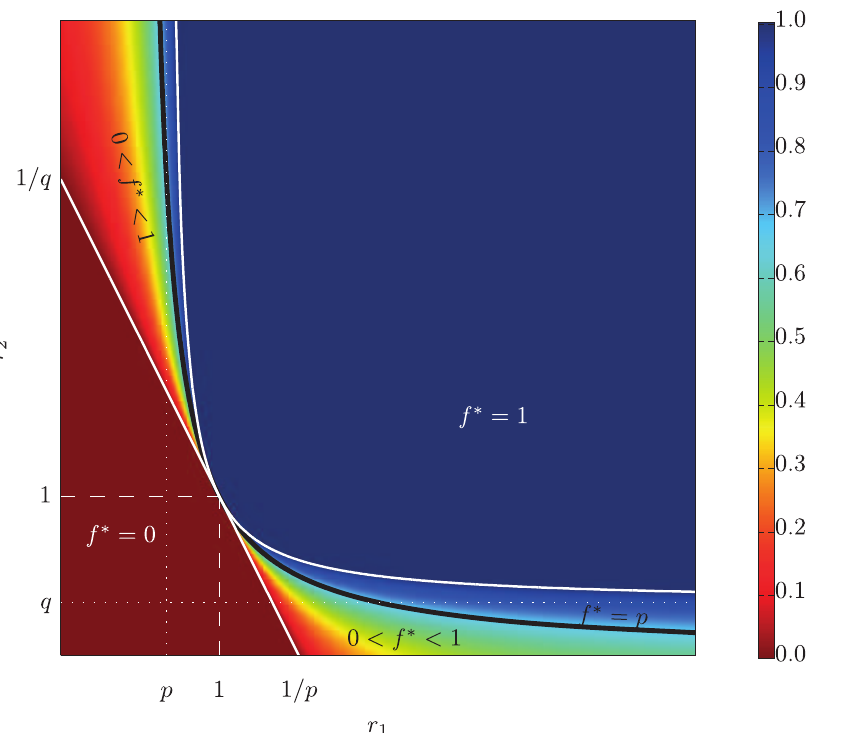
Figure 1. Regions of the ( r 1 , r 2 ) -plane that imply deterministic ( f (cid:2) ~ 0 or 1 ) or randomizing ( 0 v f (cid:2) v 1 ) behavior, where r j ~ c aj = c bj measures the relative fecundities of action a to action b in the two states j ~ 1,2 . The asymptotes of the curved boundary line occur at r 1 ~ p and r 2 ~ q . Values of r 1 and r 2 for which exact probability matching is optimal is given by the solid black curve.